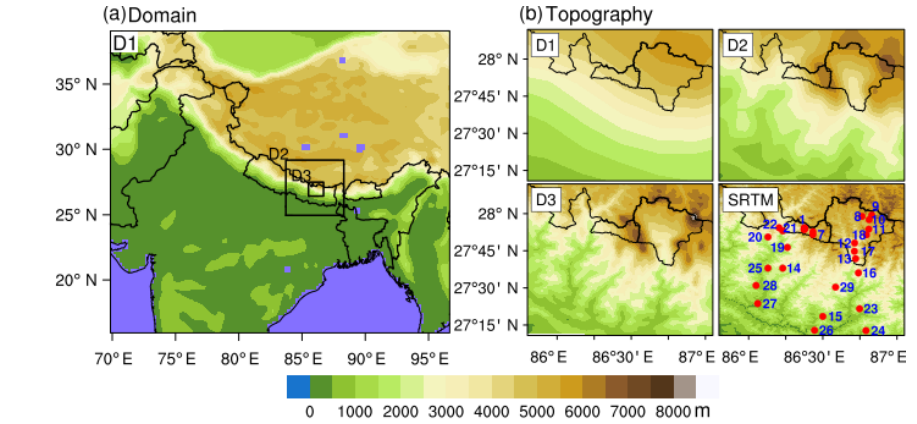
Figure 1. (a) Domain boundary of three WRF resolutions with water area marked as blue. (b) Topography of the study region at three domain resolutions – 25km (D1), 5km (D2), and 1km (D3) – and real elevation from the Shuttle Radar Topography Mission (30m resolution) with Rolwaling (left basin) and Khumbu catchments. Nepal political boundary is delineated in panel (b) . Meteorological stations (red marker) labeled as in Table 2. Due to the dense network in Rolwaling, only stations 1 and 7 out of 1–7 are labeled.